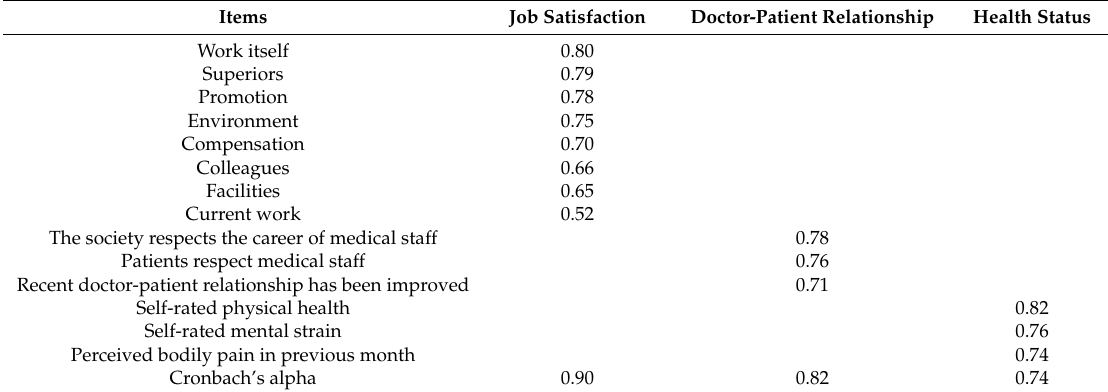
Table 1. Factor loading and Cronbach’s alpha of items across three